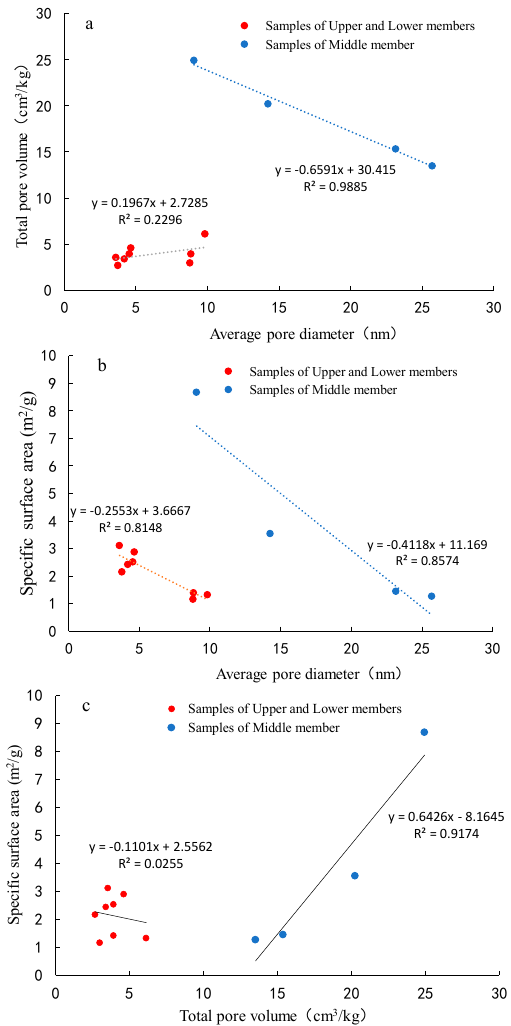
Figure 6. The interrelation of pore structure parameters of the Bakken samples. ( a ) Total pore volume